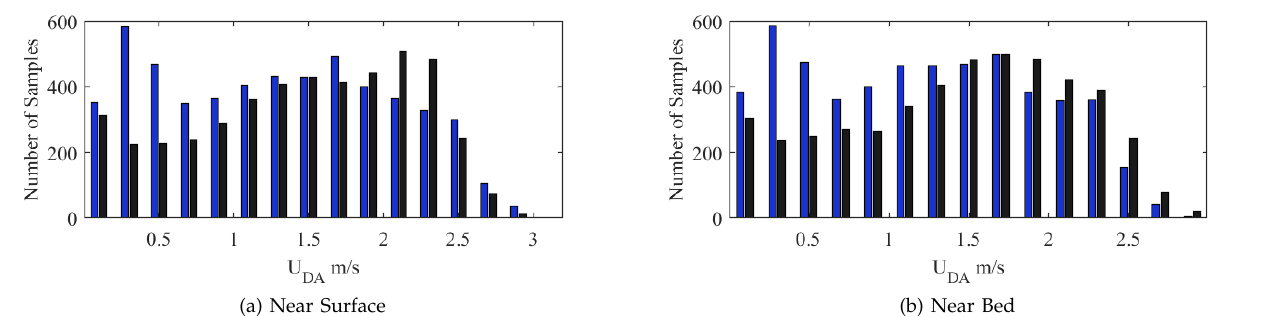
Fig. 2. Number of samples of disk averaged velocity at each hub height for the two turbine positions, for both tidal directions, flood (blue) and ebb (black).